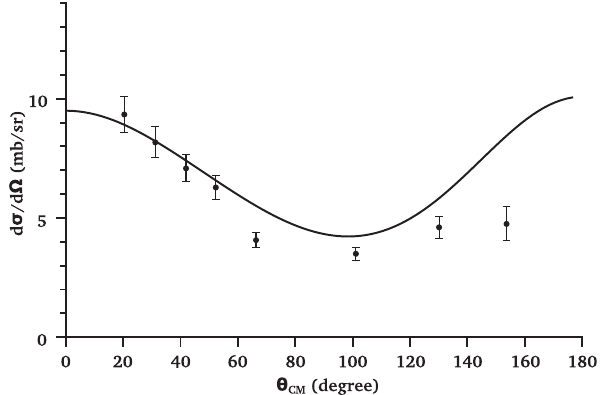
FIG. 20. Correlation of the protons laboratory angle with respect to the laboratory angle of 8 Li. The hatched area highlights the region of maximum production of 8 Li.